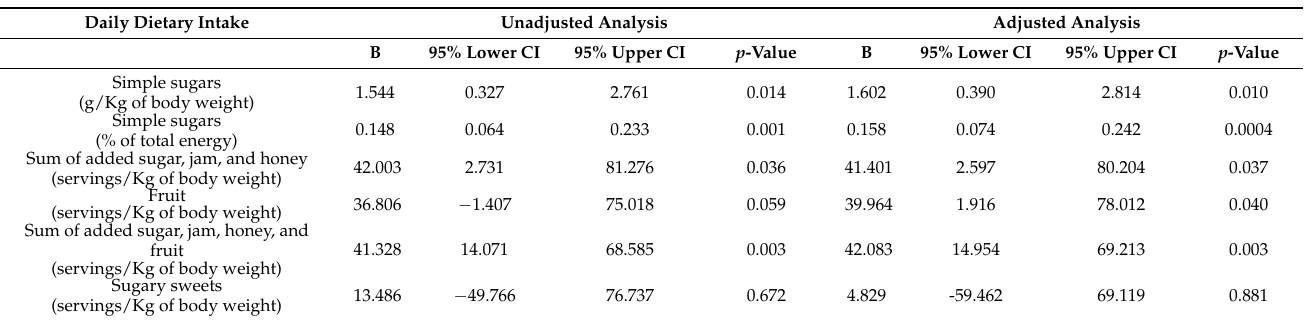
Table 4. Results of unadjusted and adjusted linear regression analyses of the association between changes in MELD score over time (DELTA-MELD) and selected daily dietary intakes in the entire cirrhotic study